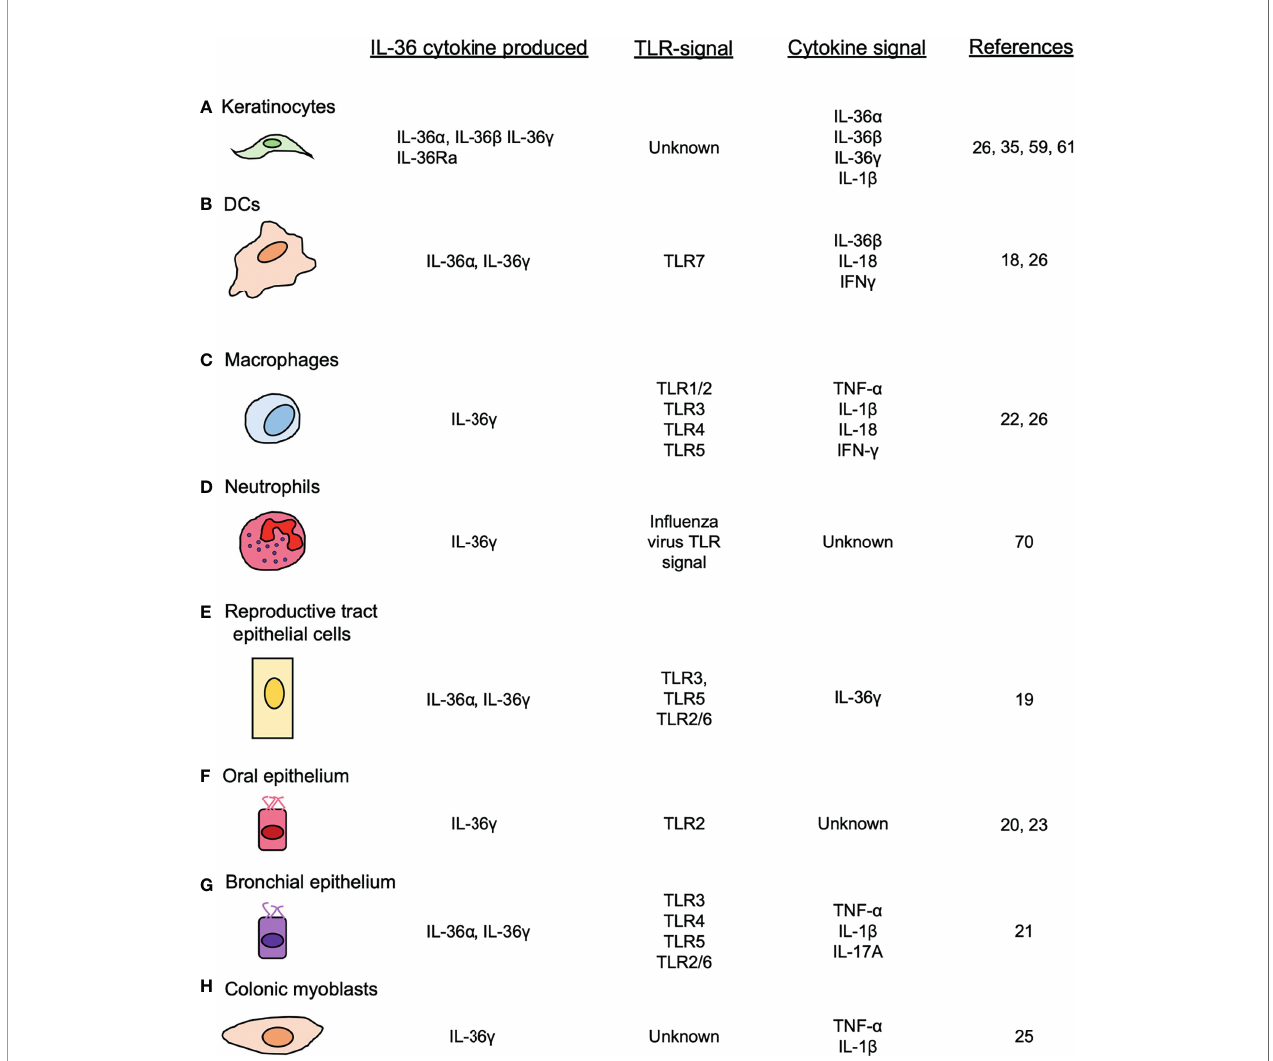
FIGURE 1 | Cellular sources of IL-36 cytokines. IL-36 cytokines are produced by different cell types, such as (A) keratinocytes, (B) DCs, (C) macrophages (D) neutrophils, (E) female reproductive epithelial cells, (F) oral epithelial cells (G) bronchial epithelial cells and (H) colonic myoblasts, after the induction of TLRs and other pro-in fl ammatory